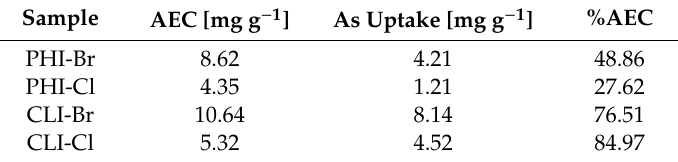
Table 2. Anion exchange capacity (AEC), As uptake and exploited AEC% for SMNZ samples.